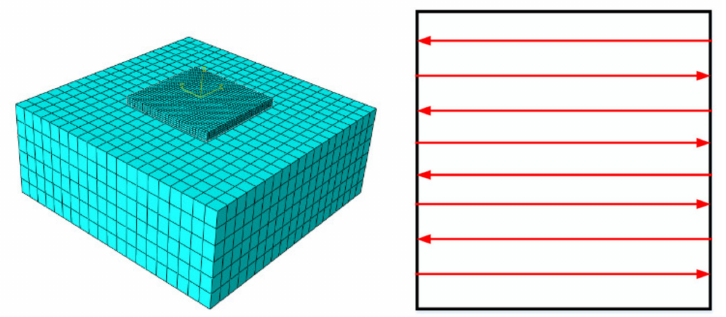
Figure 1. Finite element grid division and scanning strategy.